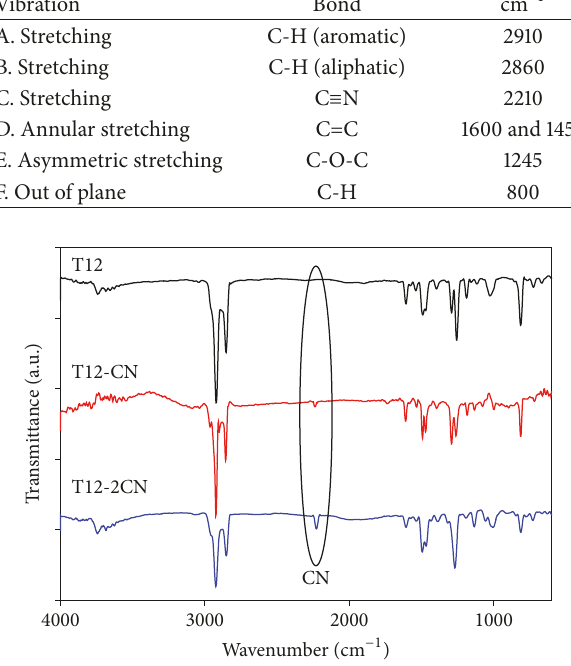
Figure 2: FTIR spectra of synthesized